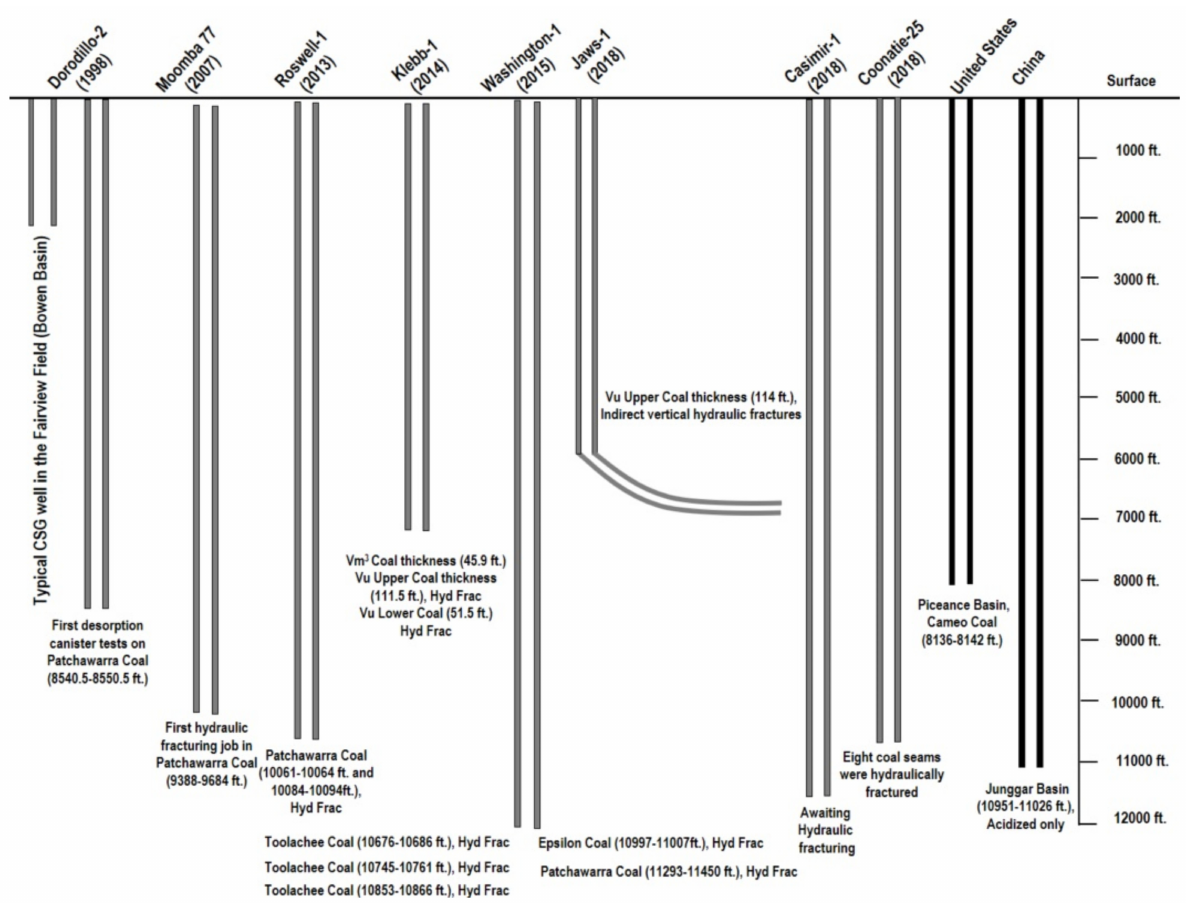
Figure 5. Dedicated deep coal wells drilled/completed in the Cooper Basin, South Australia. Moomba 77 is the first dedicated well completed in the Patchawarra coal in 2007 by the hydraulic